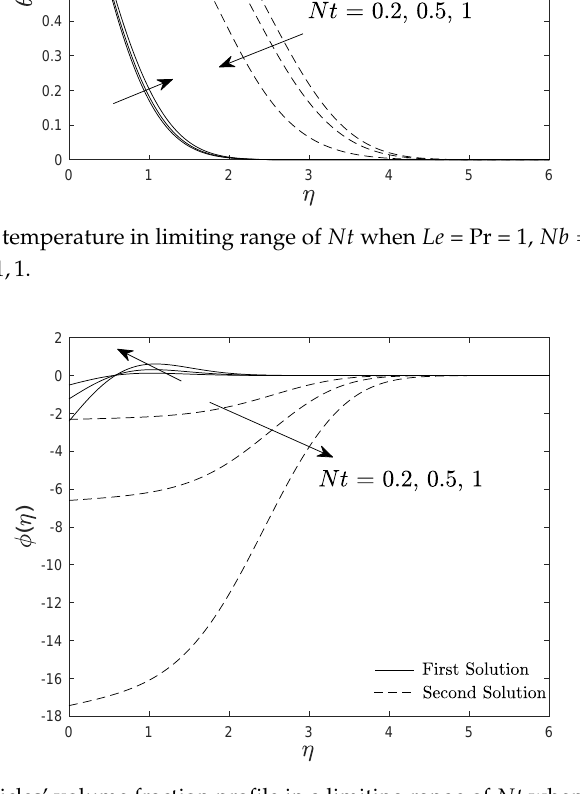
Figure 10. Nanoparticles’ volume fraction profile in a limiting range of Nt when Le = Pr = 1, Nb = 0.2, γ 1 = 5, γ 2 = 10, M = 0.5 and λ = − 1,1.